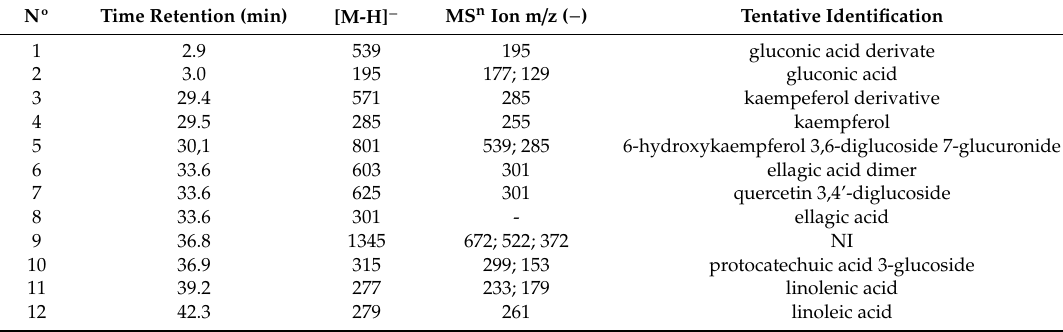
Figure 6. HPLC fingerprint (270 nm) of the hydroethanolic pollen extract collected by M. fasciculata from Chapadinha — MA. Table 2. Identification of compounds by LC-ESI-IT-MS/MS, in negative mode, of the hydroethanolic pollen extract collected by M. fasciculata from Chapadinha - MA.